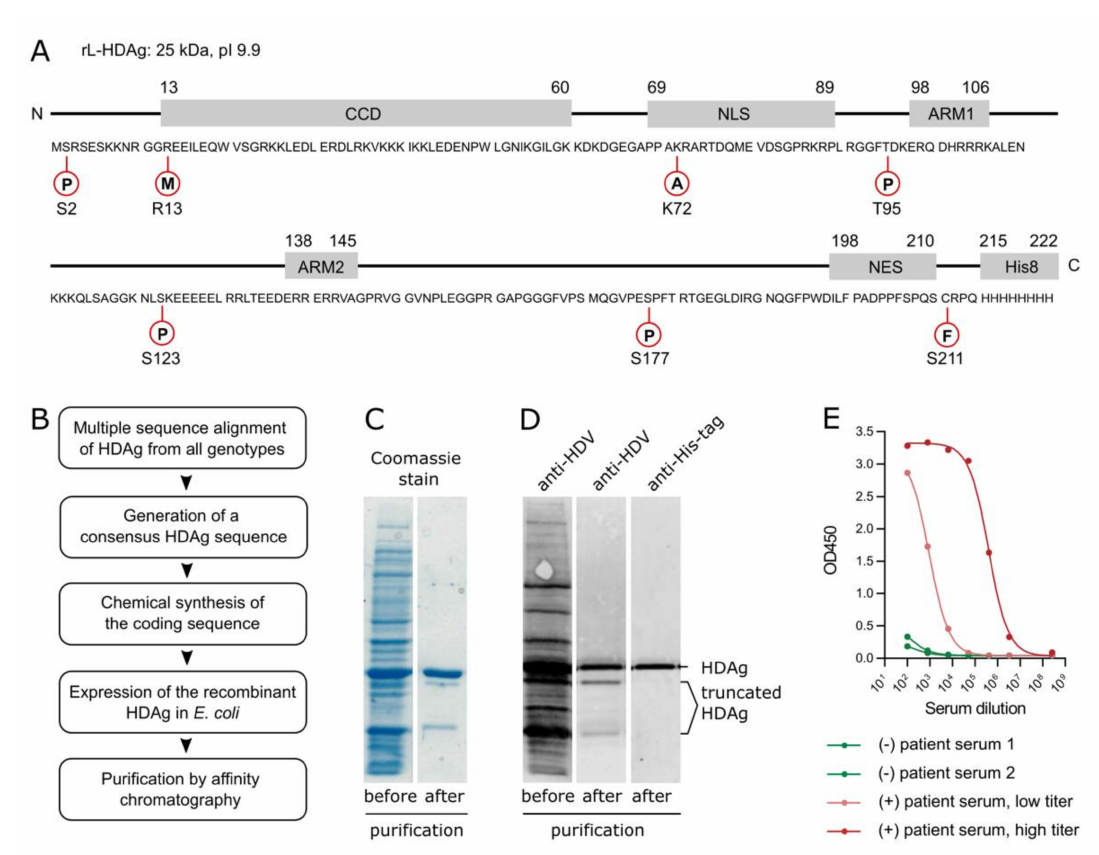
Figure 1. Development of a pan-genotypic recombinant rL-HDAg. ( A ) Optimized consensus sequence of rL-HDAg with a His-tag. All critical features and residues for post-translational modification were maintained. ( B ) Schematic of the development of rL-HDAg. The consensus sequence was derived from a multiple sequence alignment comprising 54 HDAg sequences of all HDV genotypes. ( C ) Purification of rL-HDAg and Coomassie staining. rL-HDAg was purified from bacterial pellets under denaturing conditions using a HisTrap. ( D ) Detection of rL-HDAg via Western blotting. rL-HDAg was detected by the anti-HDV-positive patient serum VUDA. ( E ) Antigenicity of rL-HDAg in a semi-quantitative in-house ELISA using anti-HDV-positive (high titer, low titer) and anti-HDV-negative patient sera.